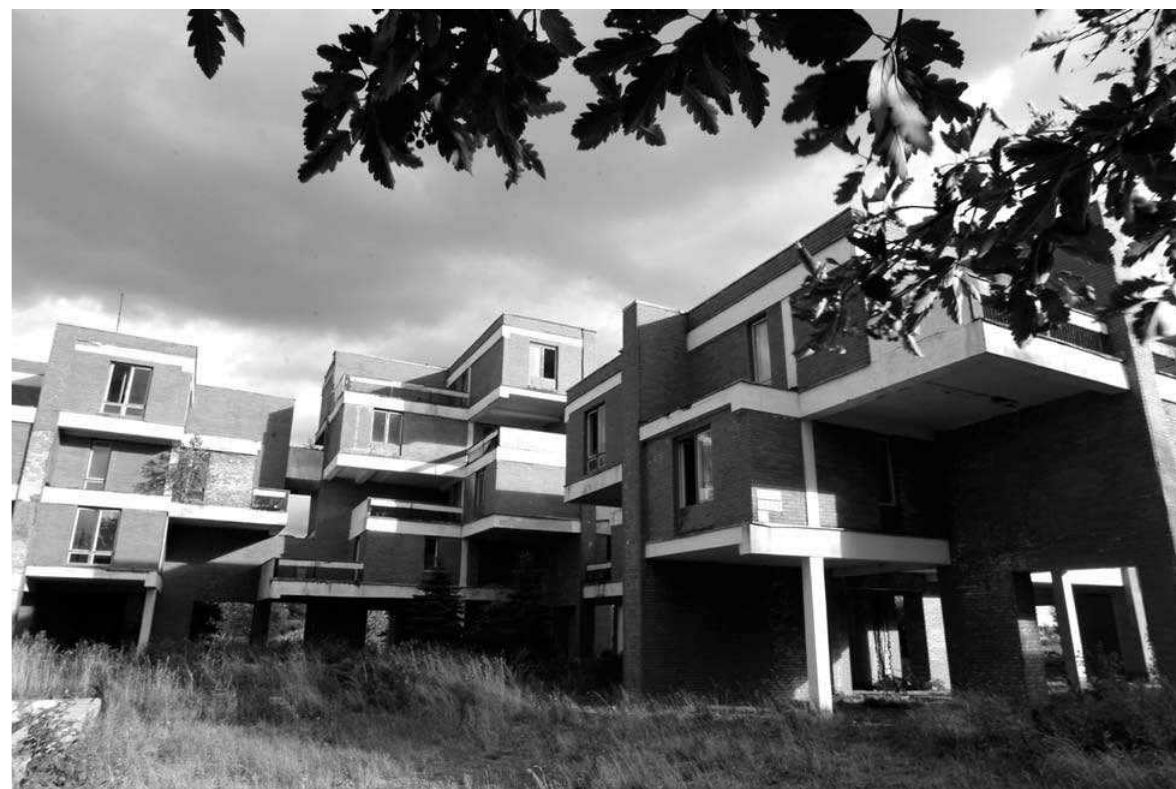
Fig 7. Resort „Guboja“ in Šventoji,